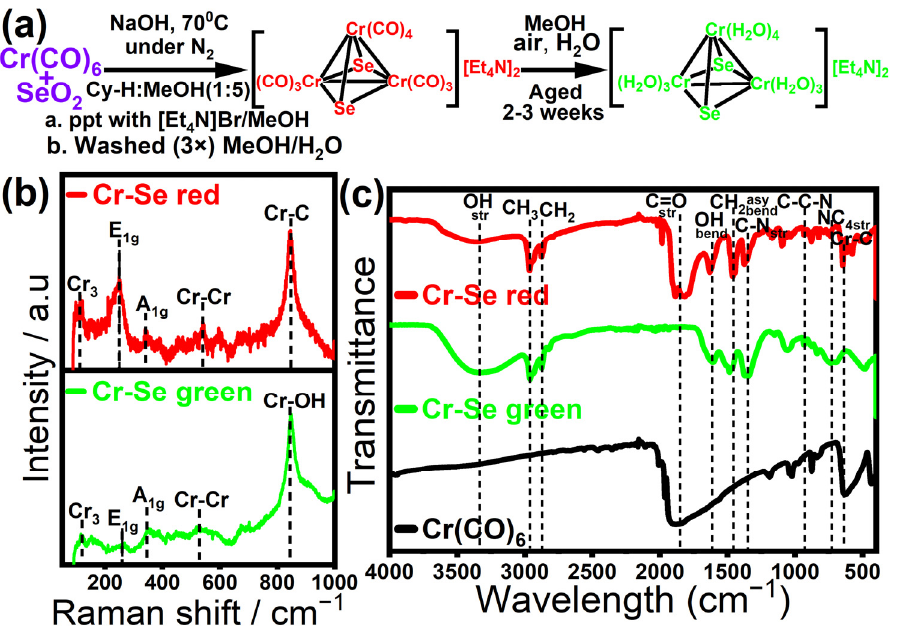
Figure 1. Synthesis and spectroscopic characterizations of Cr–Se red and Cr–Se green catalysts. ( a ) Reaction scheme describing synthesis method along with compositional details. ( b ) Raman spectra, excited with 632.8 nm HeNe laser radiation; ( c ) FTIR spectra.